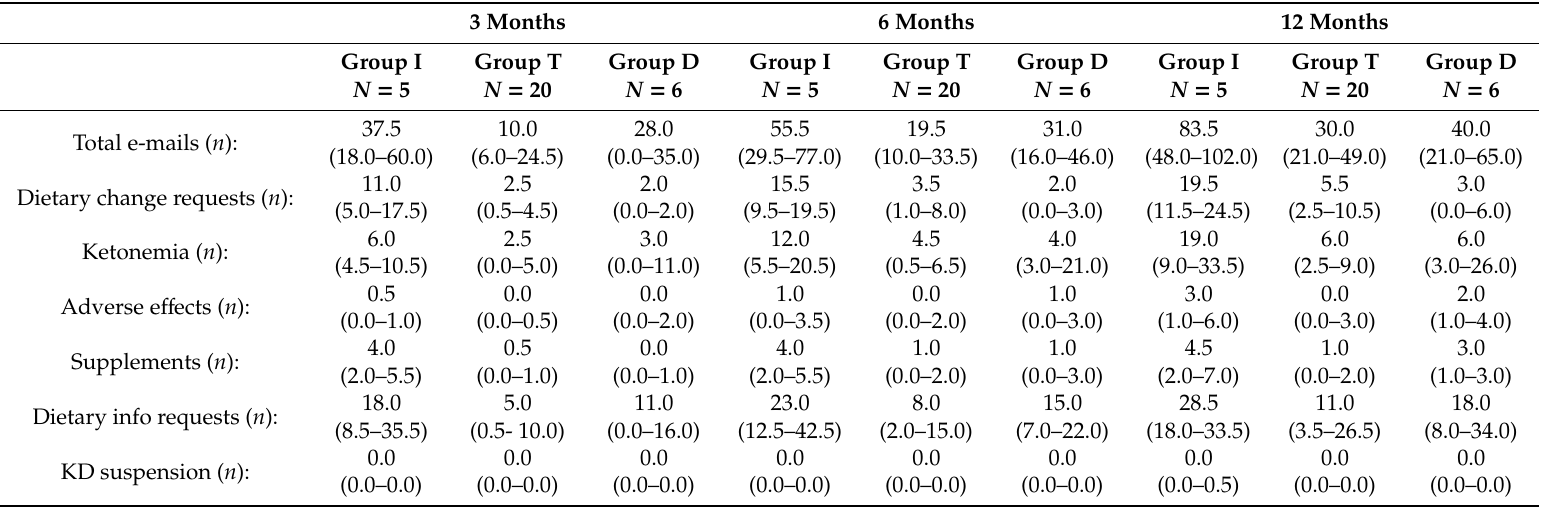
Table 4. E-mail monitoring in the three di ff erent growth